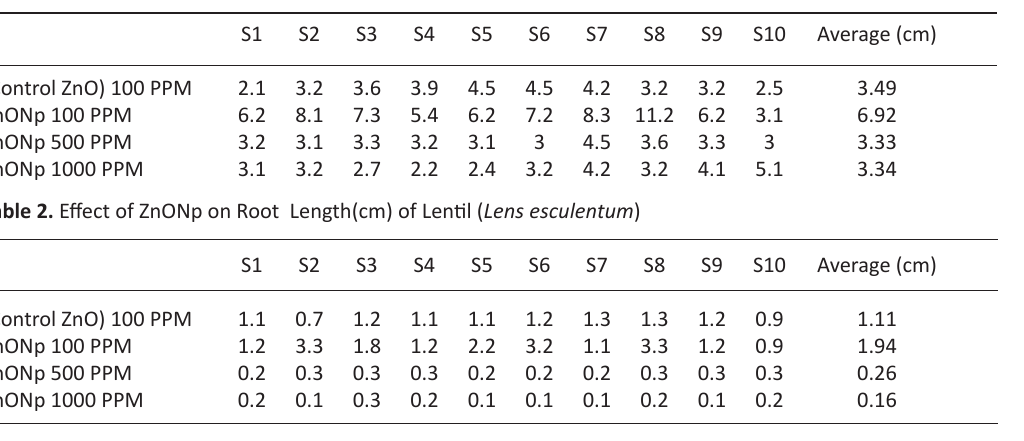
Table 1. Effect of ZnONp on shoot Length(cm) of Lentil ( Lens esculentum ) S1